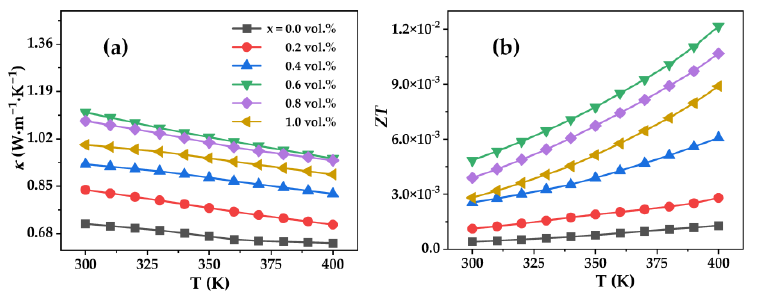
Figure 7. Temperature dependences of ( a ) thermal conductivity, ( b ) ZT for the Bi 0.5 Sb 1.5 Te 3 /CNTs cement composites.